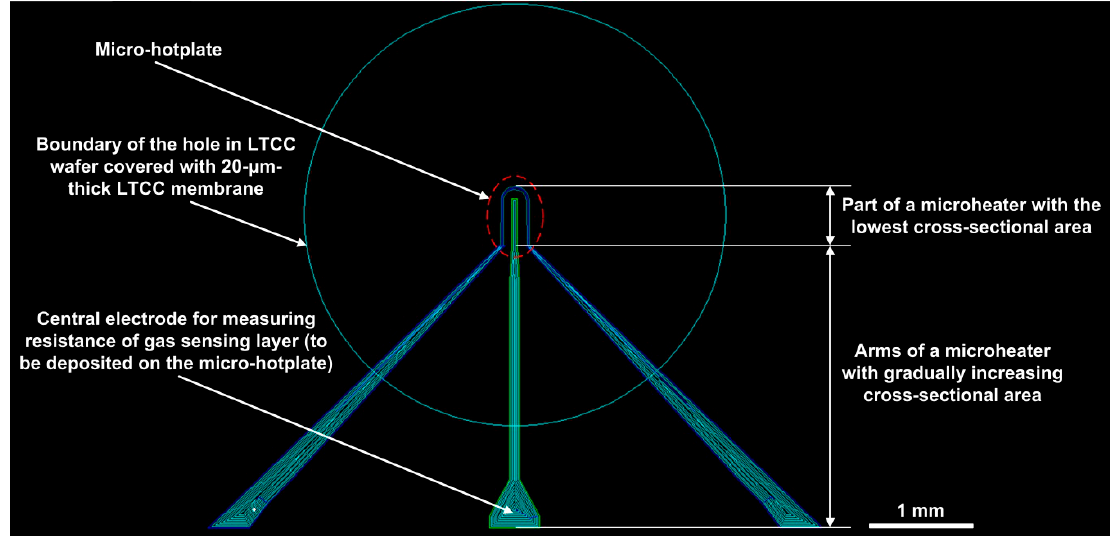
Figure 1. Stencil of a microheater used for aerosol jet printing.